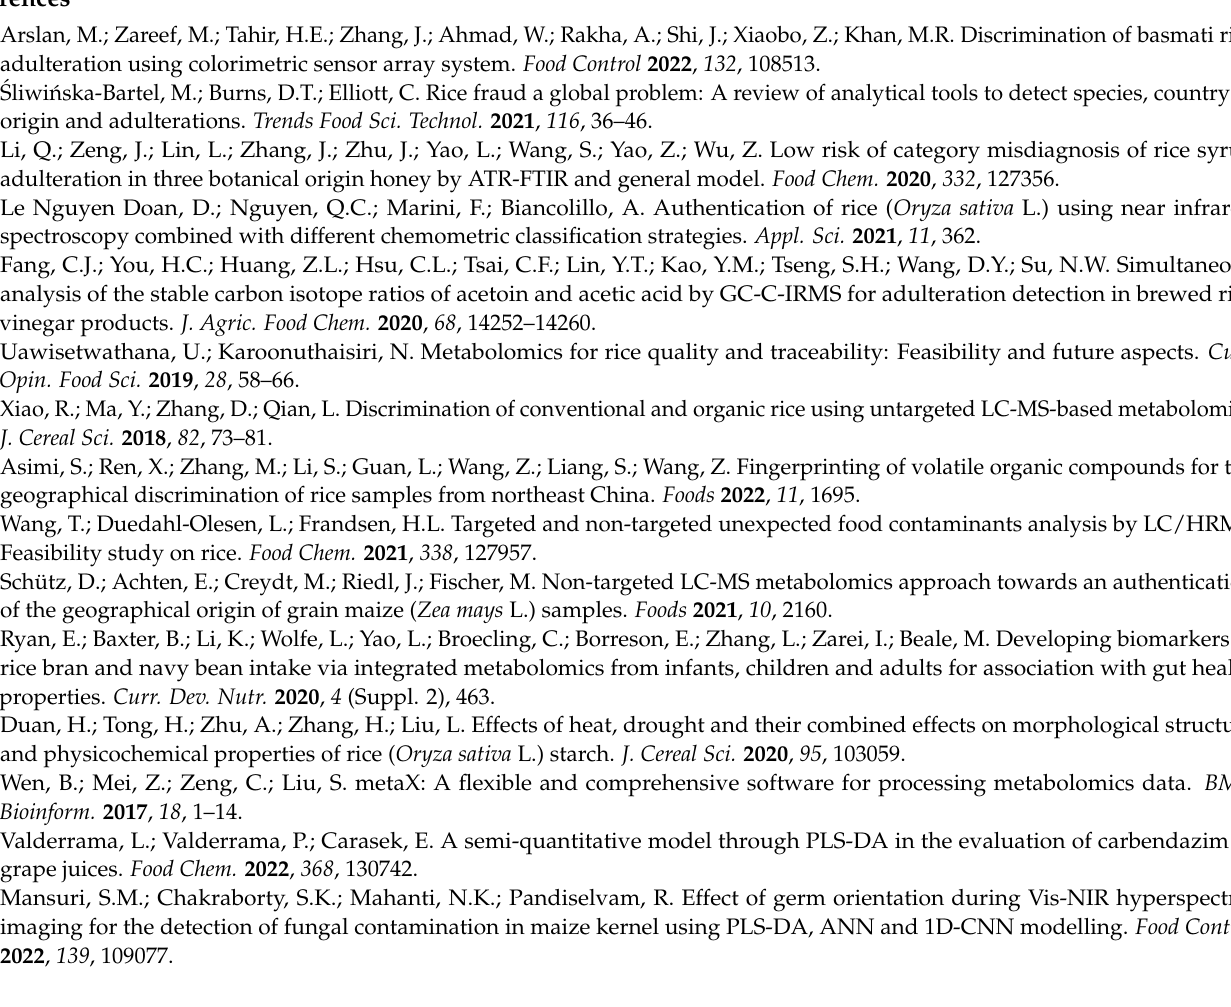
Table S3: Condition parameter settings of